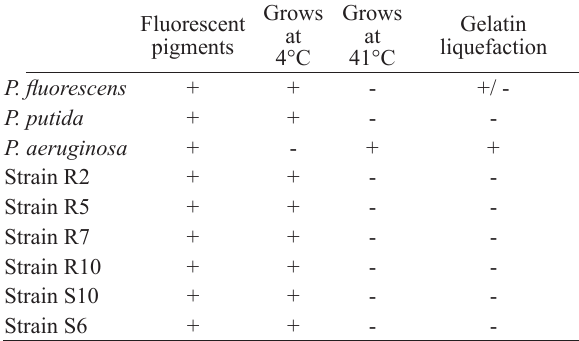
Table 3. Reaction of different strains of Pseudomonas spp. to the biochemical